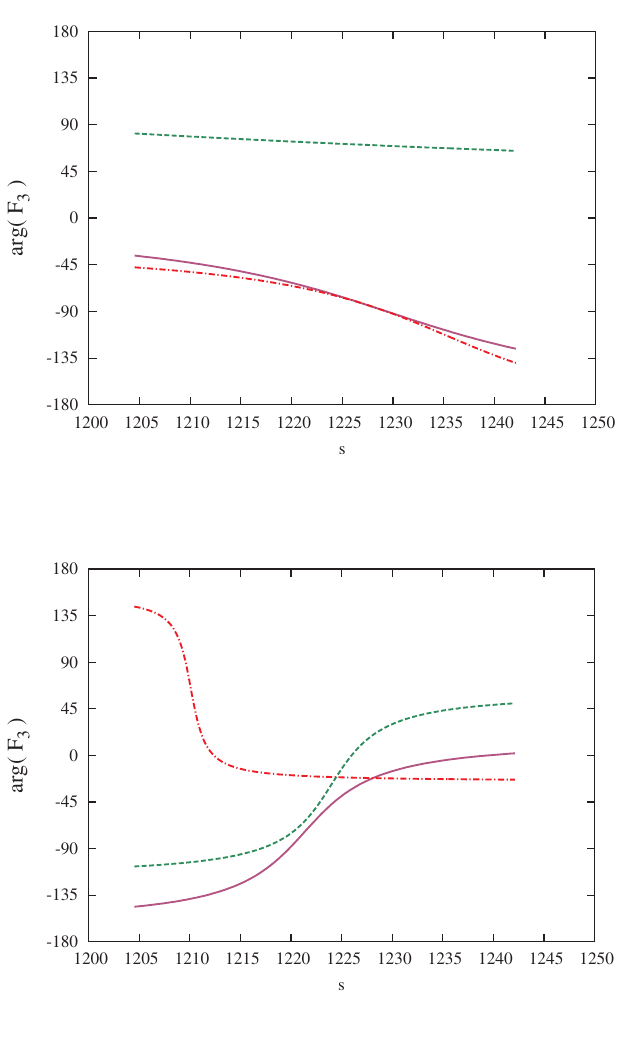
Þ at 205 GeV in the drift space FIG. 5. (Color) Graph of arg ð F 3 L232 of RHIC for three scenarios: (a) solid (purple)—no rotators, (b) dashed (green)—longitudinal polarization at both STAR and PHENIX, (c) dot-dashed (red)—no rotators at STAR, radial polarization at PHENIX. The horizontal axis shows the arc length in meters, measured from the 6 o’clock point.